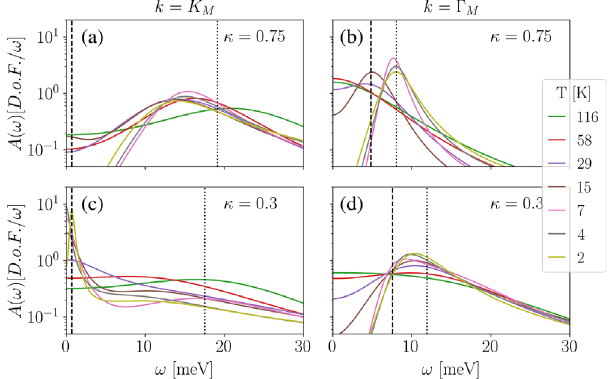
FIG. 3. Spectral function A ð ω ; k Þ , summed over band, valley, and spin, at the Dirac point k ¼ K (a,c) and the BZ center M k ¼ Γ (b,d) for κ ¼ 0 . 75 (top row) and κ ¼ 0 . 3 (bottom row) M and L ¼ 9 × 9 . The dashed vertical lines indicate the noninter- acting excitation energy, shifted by the charging energy; the dotted line represents the interaction-only limit. We find that the spectra for κ ¼ 0 . 75 are in fairly good agreement with the excitation energies of the interaction-only limit. For κ ¼ 0 . 3 , instead, sharp peaks arise at low temperatures at the Dirac point k ¼ K ; their energy agrees with the finite-size charging energy, M indicating the semimetallic phase. Note the spectral weight at ω ∼ (cid:2) 15 meV, reminiscent of the purely interacting mode. One cannot distinguish those two modes at k ¼ Γ